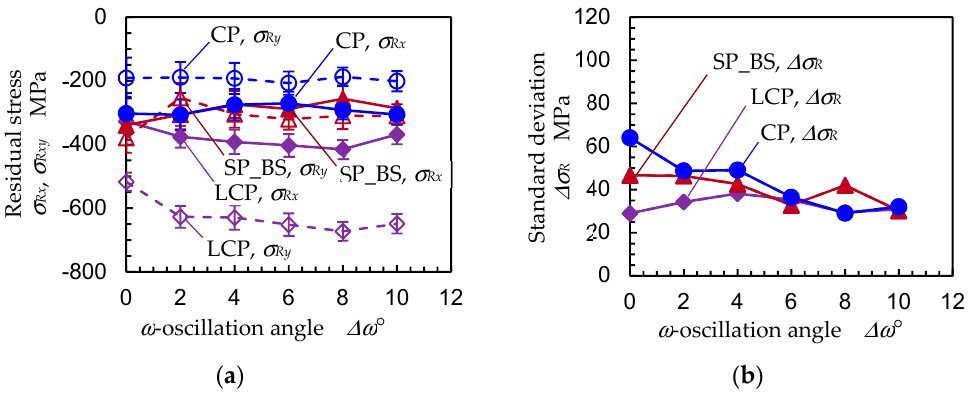
Figure 13. Effect of the ω -oscillation angle ∆ ω on the residual stress measurement of stainless steel using the 2D method ( d col = 0.146 mm, t exp = 20 min); CP: specimen A, LCP: specimen B, SP_BS: specimen C; ( a ) residual stress; ( b ) standard deviation of residual stress.